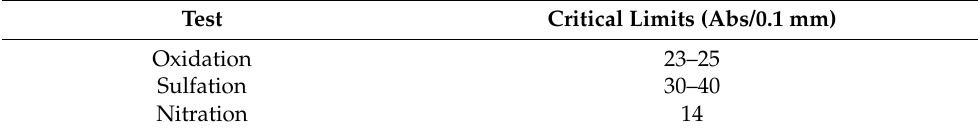
Table 2. Critical limits of the three lubricant oil degradation parameters under study [26,27].